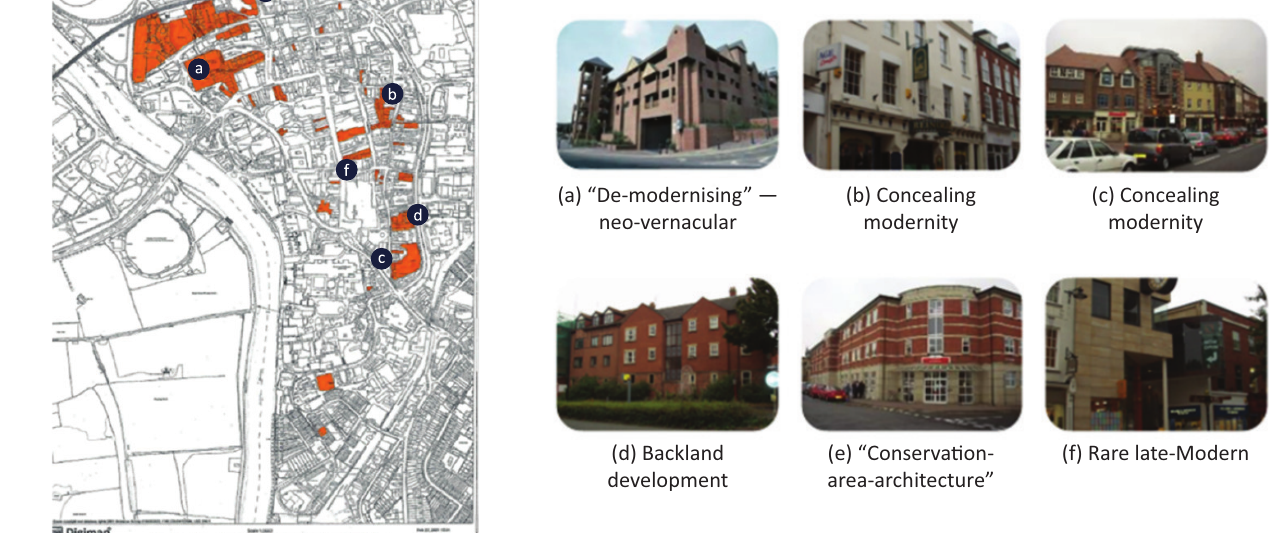
Figure 5. The location of new build development proposals between 1987–1997: The heritage map of backland develop‐ ment and concealed modernity. Base‐map on the left by Digimap and on the right annotations and photos by the